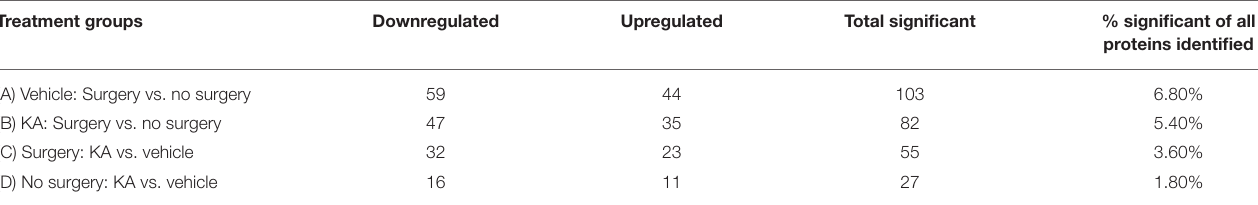
TABLE 1 | Comparison of the changes in the expression of proteins in the hippocampus between treatment groups are reported as absolute numbers and percentage of total identified proteins. Treatment groups